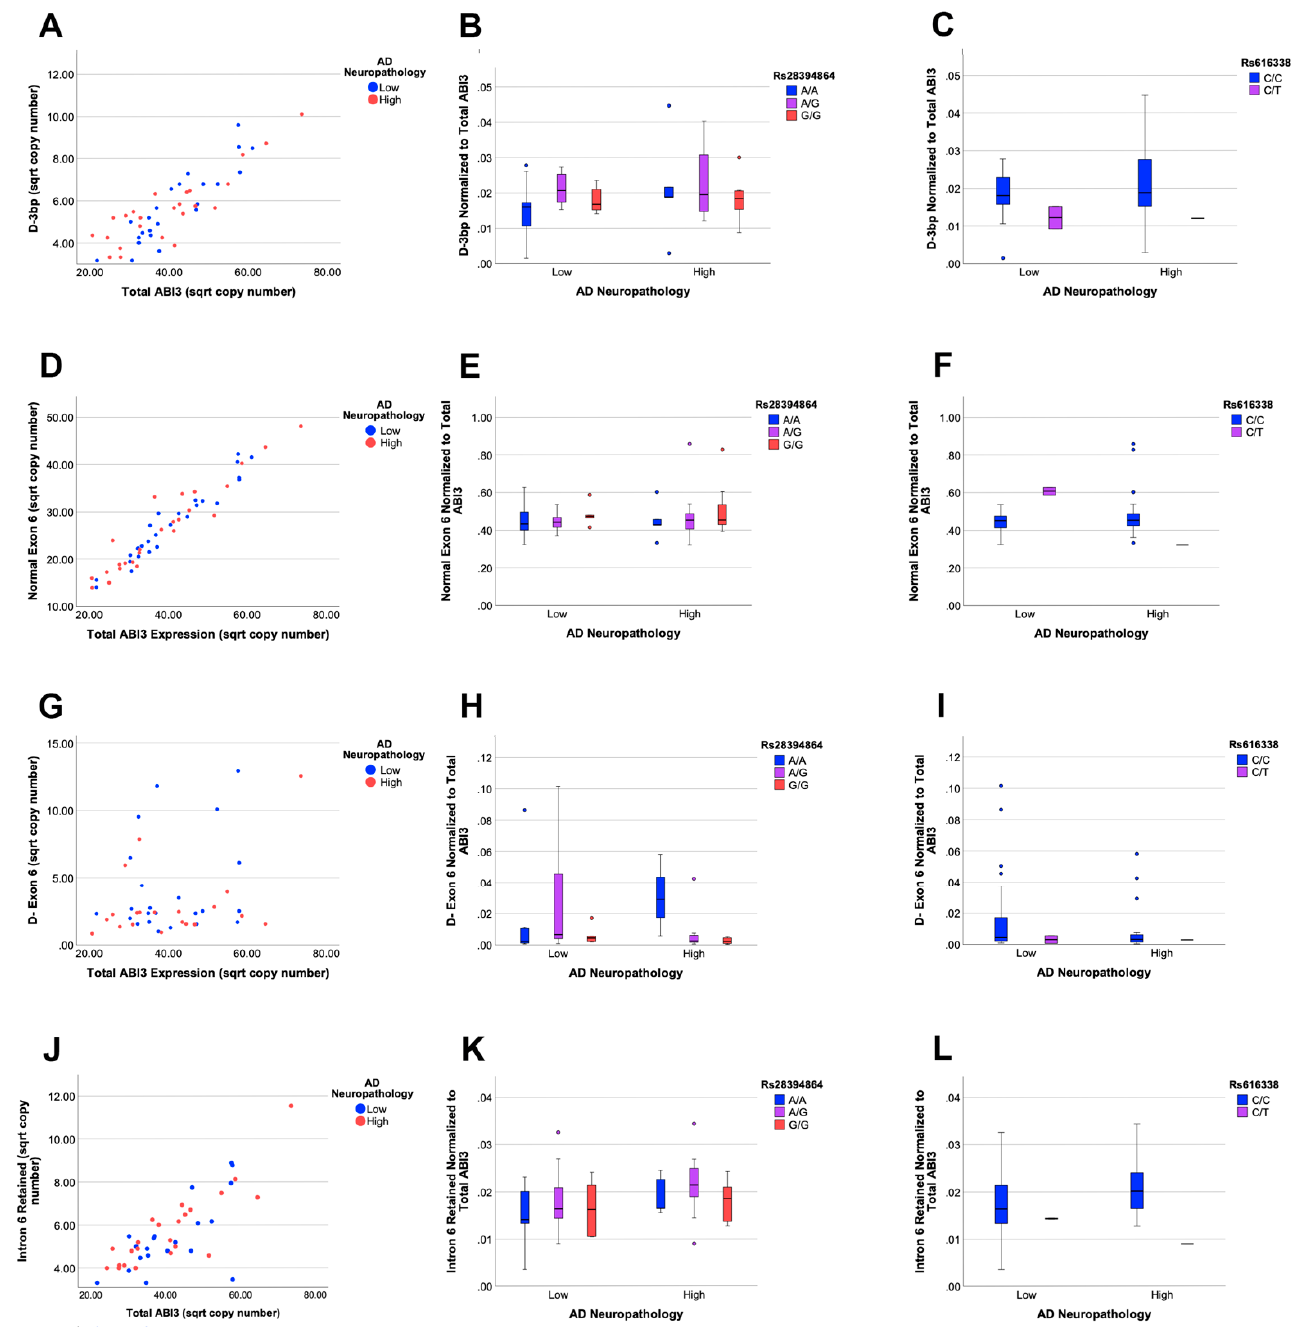
Figure 4. ABI3 isoform expression is not influenced by AD neuropathology or genetics. The expression of the D-3bp isoform correlates with expression of total ABI3 ( A ). D-3bp expression was not significantly influenced by AD neuropathology or either SNP, but did trend with rs616338 ( B , C ). The expression of ABI3 with prototypic exon 6 strongly correlates with the expression of total ABI3 ( D ) but was not significantly influenced by AD neuropathology or either SNP ( E , F ). Expression of ABI3 lacking exon 6 showed more variability than the other isoforms but also was not significantly influenced by AD neuropathology or genetics ( G – I ). Expression of ABI3 with retained intron 6 correlated well with the expression of total ABI3 ( J ). This isoform was not significantly influenced by AD neuropathology or either SNP, but did trend with rs616338 ( K , L ).